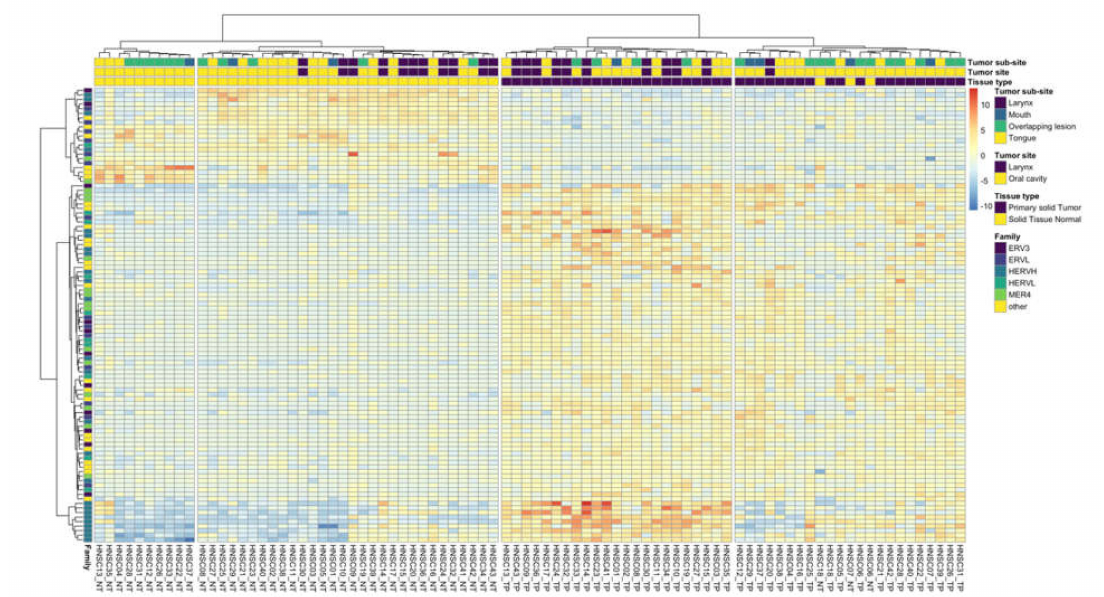
Figure 2. Expression for the top 100 differentially expressed HERVs. Heatmap colors represent the difference between each sample’s expression level and the mean expression level of each HERV (sample expression − mean expression). Row colors indicate HERV family membership. HERV families with five or fewer members present in the top 100 differentially expressed HERVs are presented as